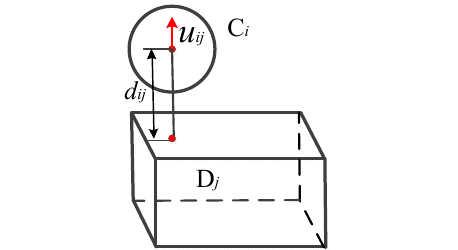
Figure 13. Schematic diagram of minimum distance between virtual spheres and obstacles.